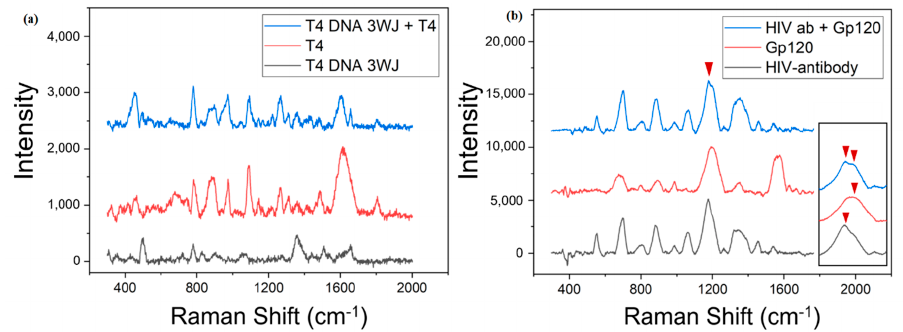
Table 1. Assignments of SERS peak of Thyroxine.